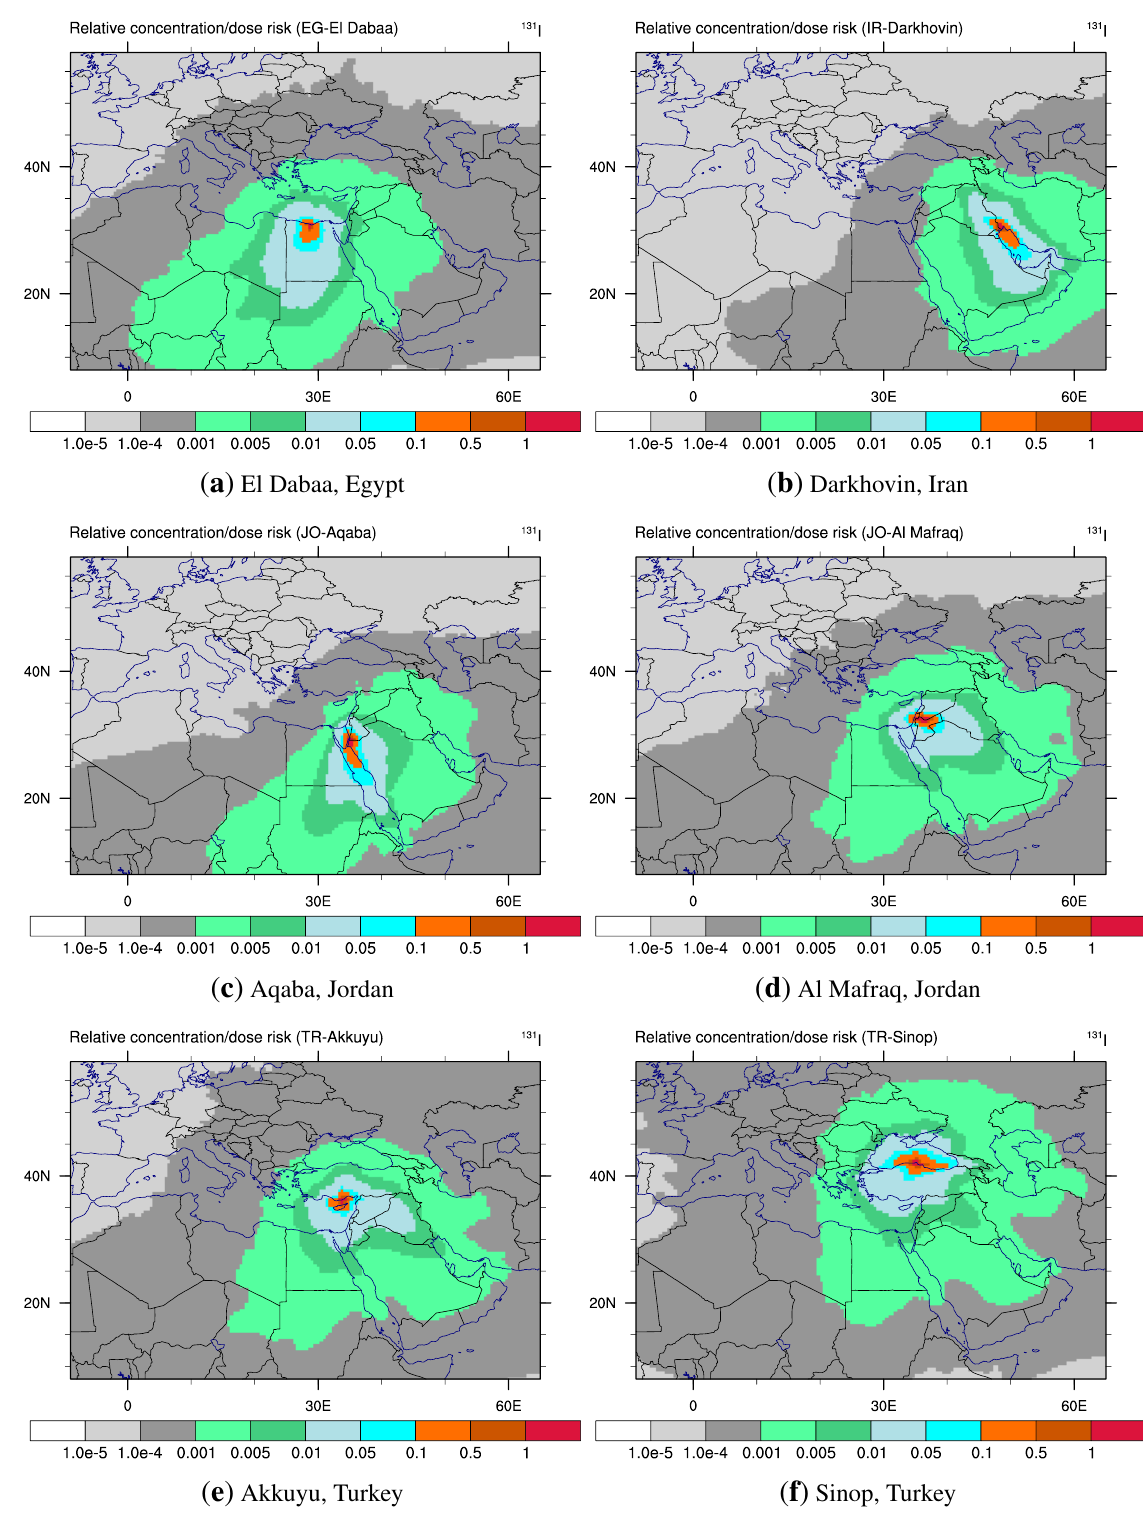
Figure 5. Individual and combined bottom relative surface level gaseous 131 I concentration and human population dose risk from potential nuclear power plant (NPP) accidents in the EMME region